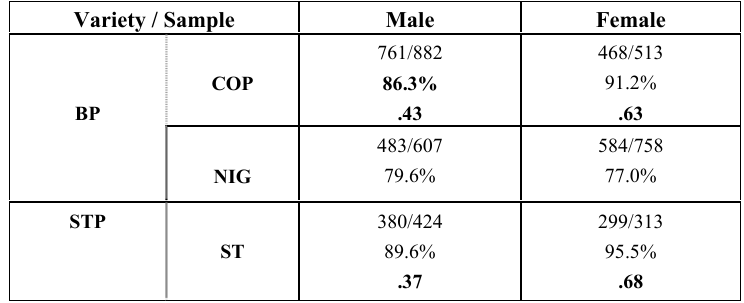
Table XVI: Third person plural verbal marking and Sex/Gender by variety of Portuguese Variety /